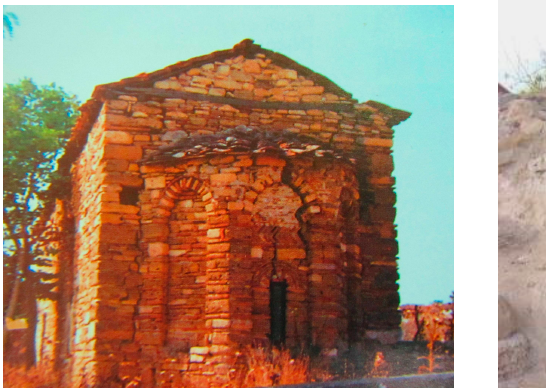
Figure 24. The church of Ipapanti in the centre of Kalamata.